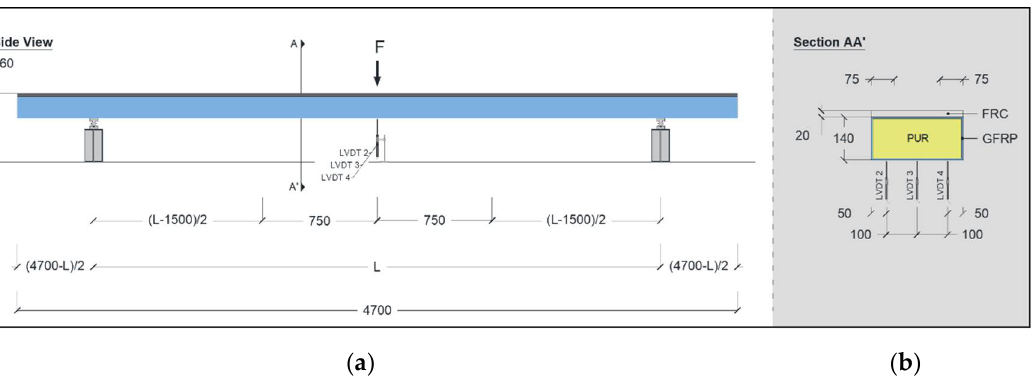
Figure 4. Geometry, test set-up, and instrumentation for the static test with variable span: ( a ) side view and ( b ) cross-section view. Units in